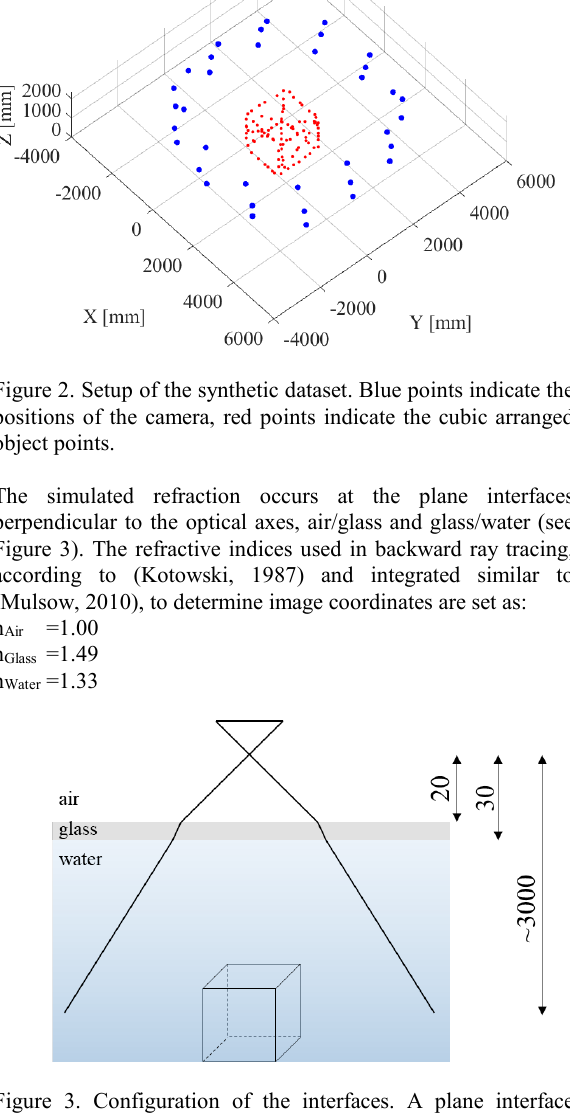
Figure 3. Configuration of the interfaces. A plane interface (10mm in thickness) of glass is simulated 20mm in front of the principal point. The average distance to the object points is approx. 3m.